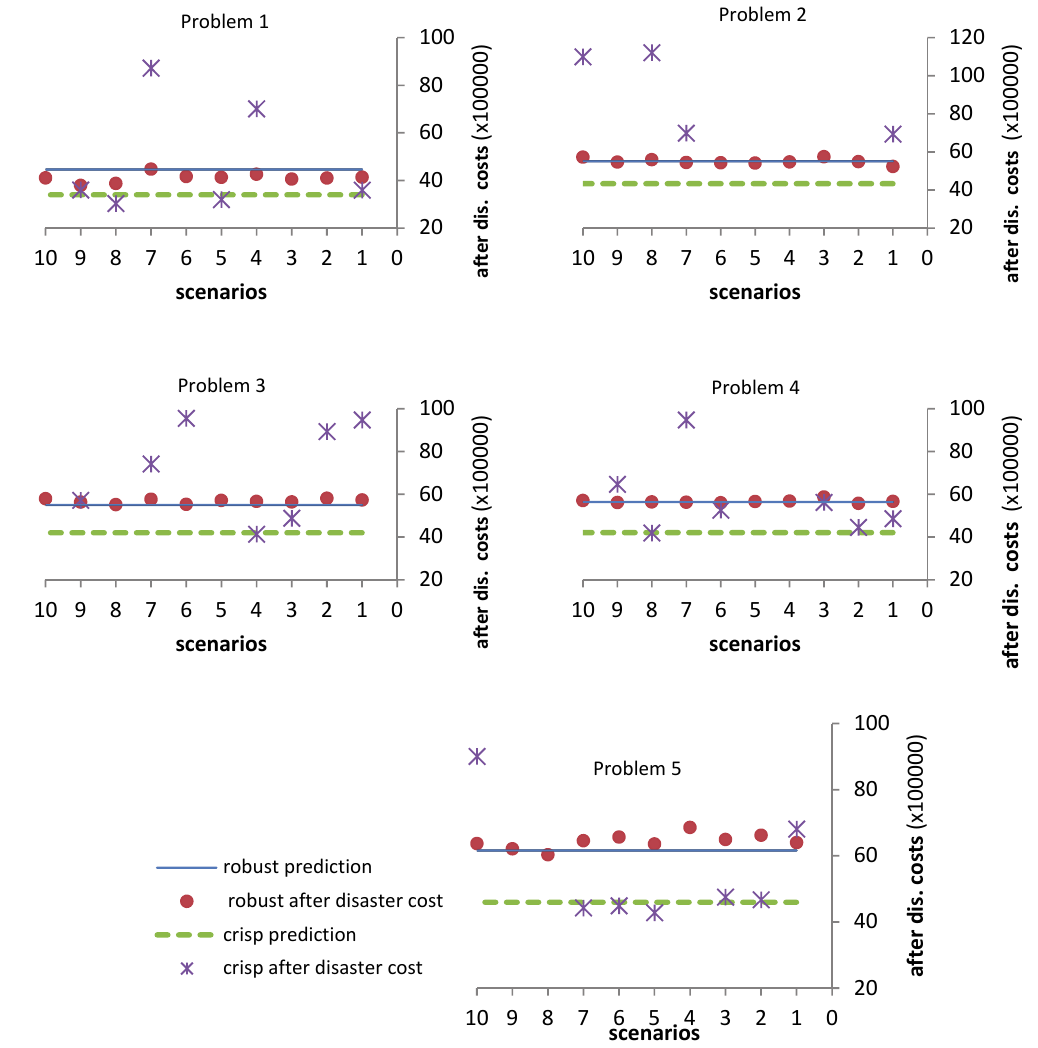
Fig. 3. Evaluation of the after disaster costs for both deterministic and robust models in five test